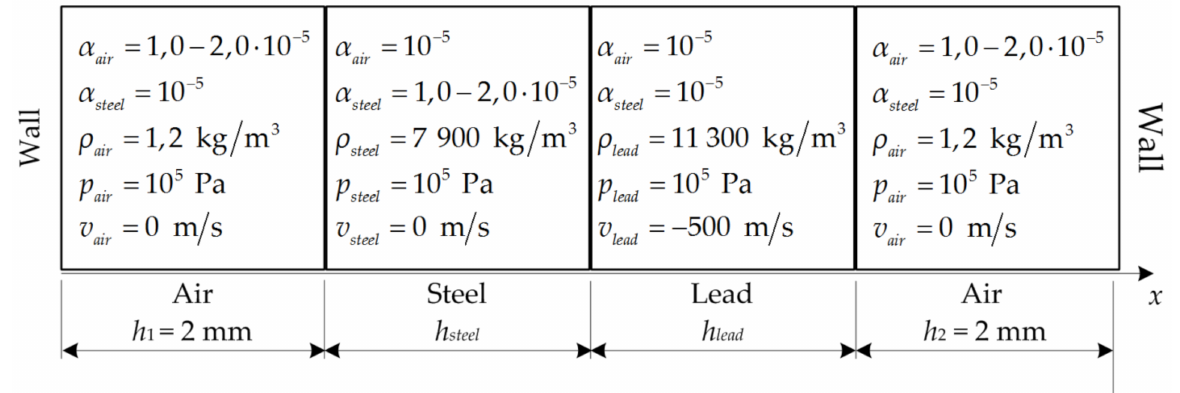
Figure 1. Schematic of the problem about a high-speed normal impact of two metal